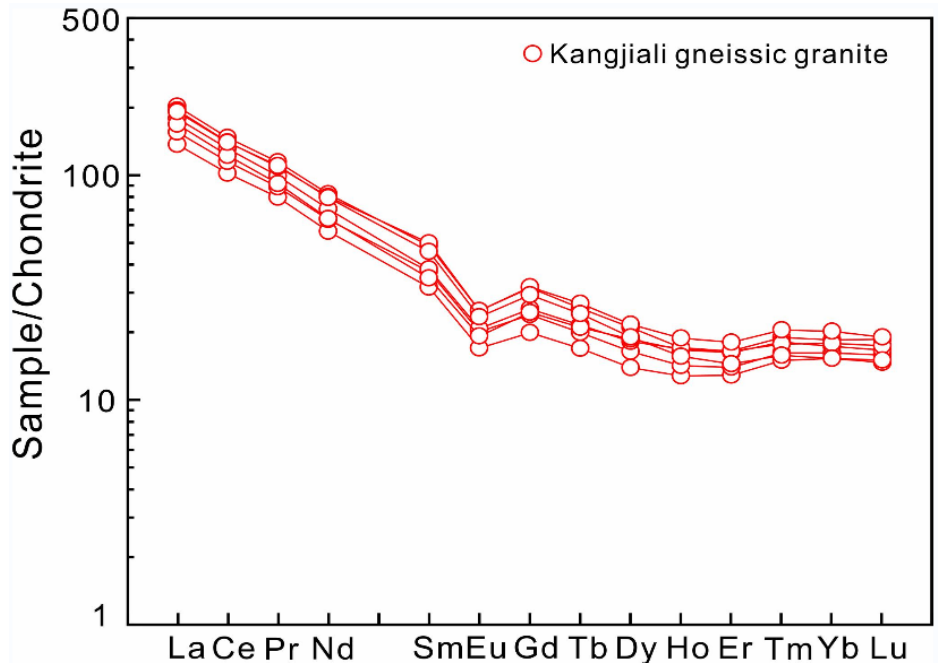
Figure 7. Chondrite-normalized rare element (REE) diagram of the Kangjiali gneissic granite. Chondrite data are from Sun and McDonough (1989) [26].